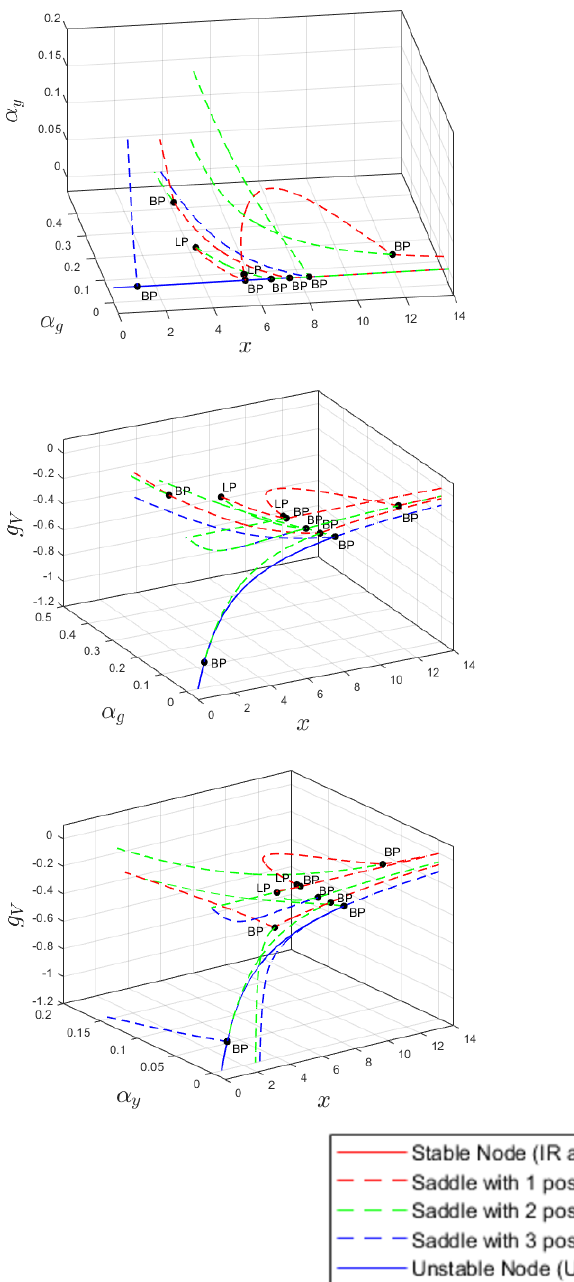
g ; (cid:11) y )-space, ( x; (cid:11) g ; g S )-